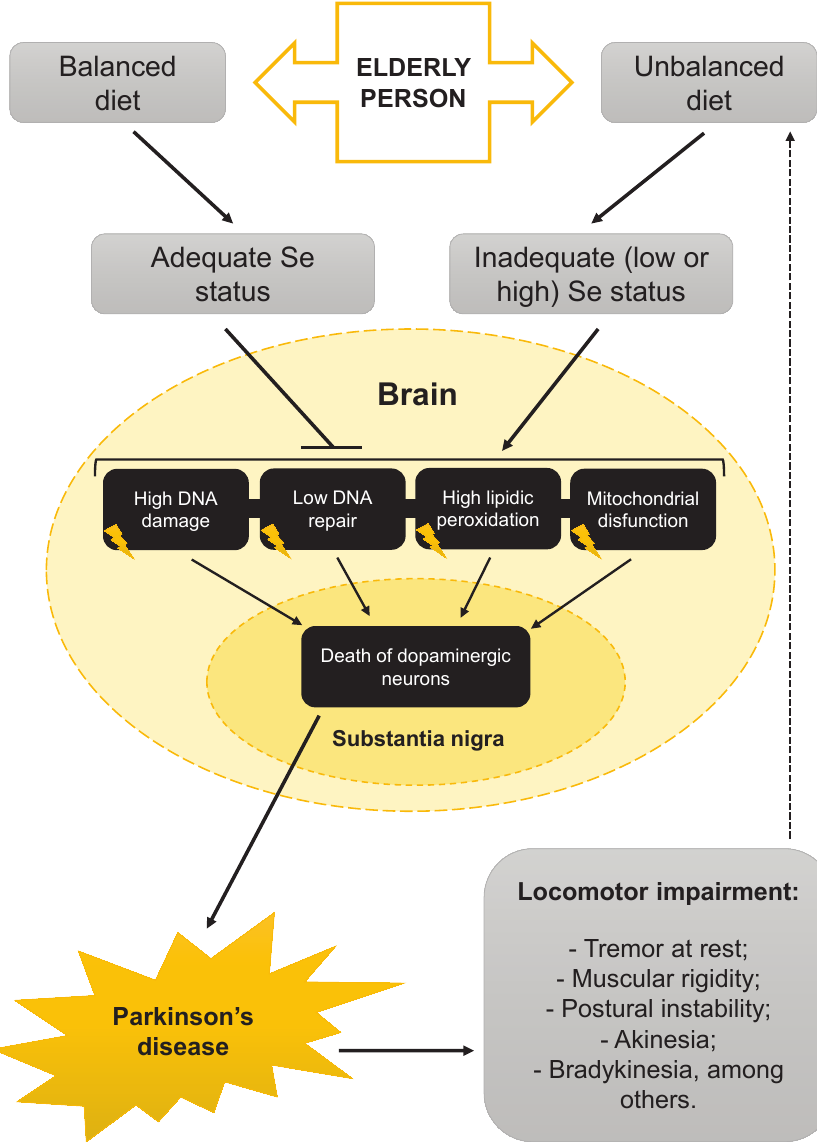
Figure 3 - Probable (hypothetical) relationship between nutritional status of Se and events that culminate in PD. Elderly individuals are susceptible to dietary imbalances that may cause inadequate nutritional Se. Inadequate levels of Se (high or low) in the brain cause co-interacted events that culminate in the death of dopaminergic neurons in the substantia nigra; however, adequate levels of Se protect against these events. The neuronal death of dopaminergic neurons leads to PD, which affects the locomotor system. This locomotor impairment can cause damage to the lives of individuals affected by disease as well as inadequate